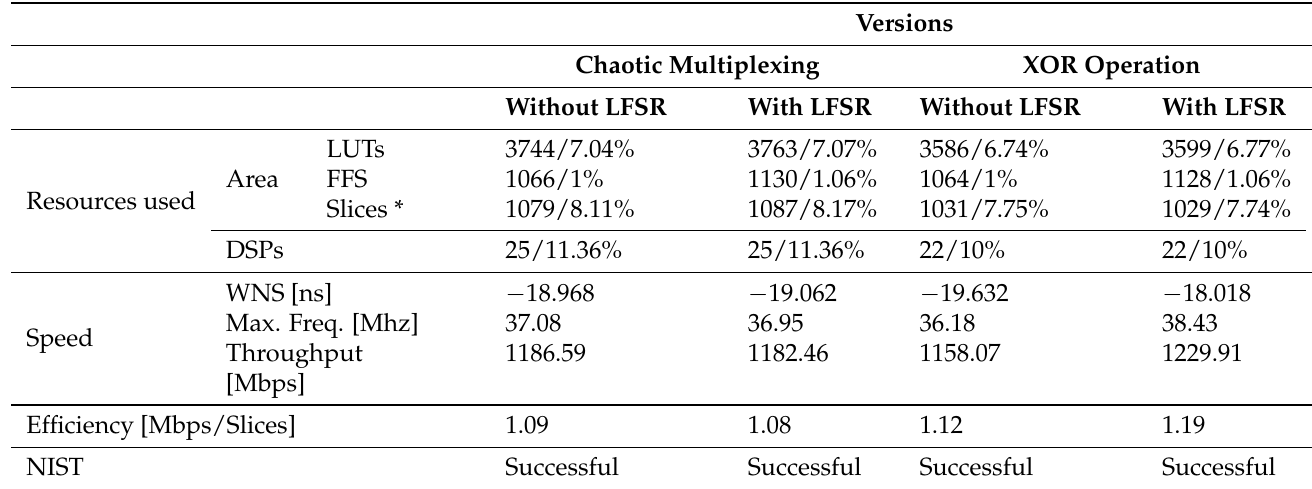
Table 2. Comparison of the proposed SPCNG design versions on ZYNQ PYNQ Z2